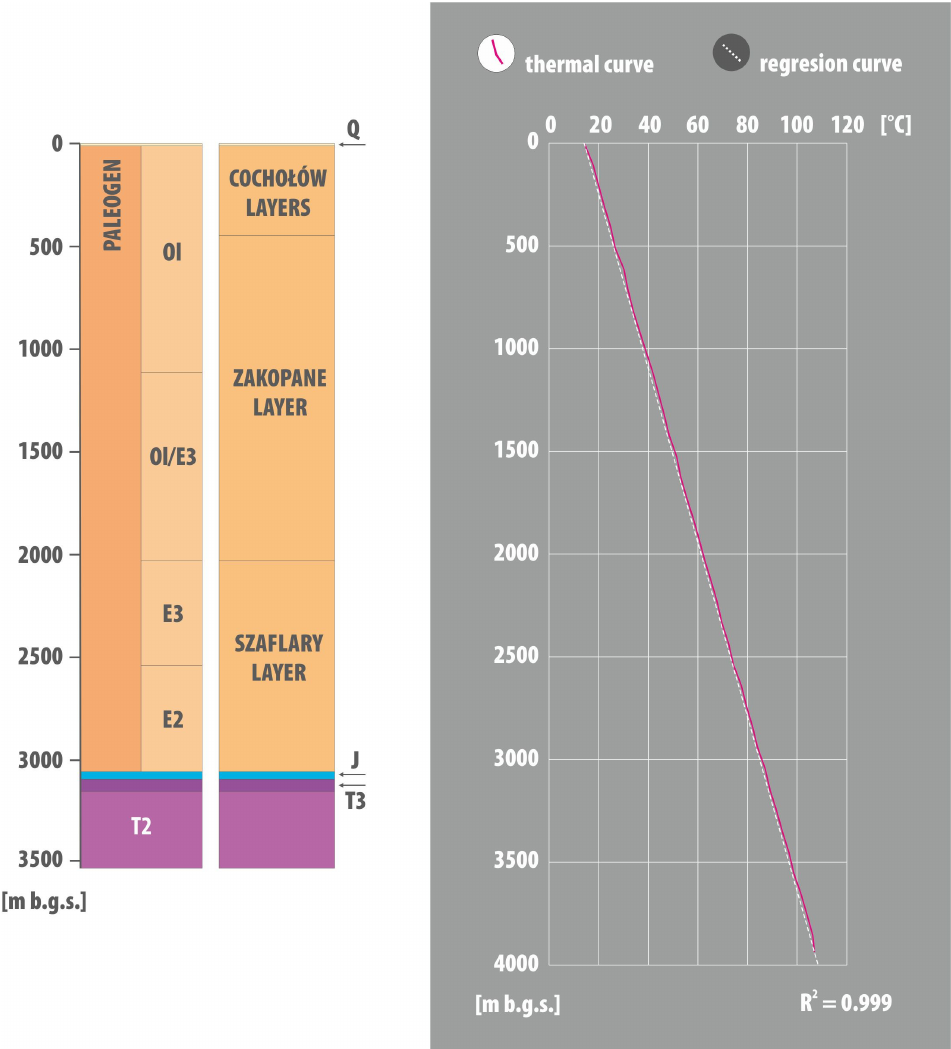
Figure 4. Lithostratigraphic profile and thermal curve for the C-PIG-1 geothermal well (based on [29,38,39]).